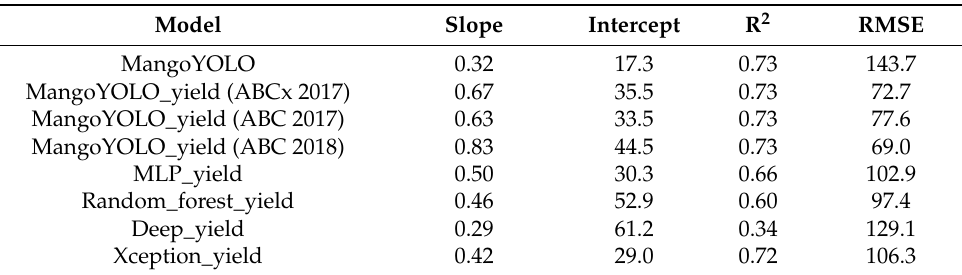
Table 12. Regression statistics for prediction of fruit load per tree, relative to human count. The result for the raw MangoYOLO prediction is included for comparison. Test set prediction results for ABC 2018 season sample trees using five methods, trained with ABC-x 2017 images. The data set used for estimation of occlusion factor in MangoYOLO_yield method is shown in brackets. Unit for slope, bias and RMSE is